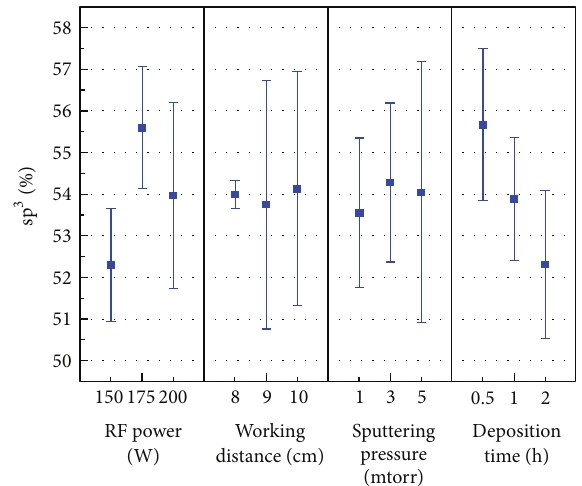
Figure 1: Response graph of the four factors versus sp 3 content. The ranking order of the magnitude of sp 3 content at various levels indicates that the effects of various factors on the sp 3 content are ranked in the following order: deposition time, RF power, sputtering pressure, and working